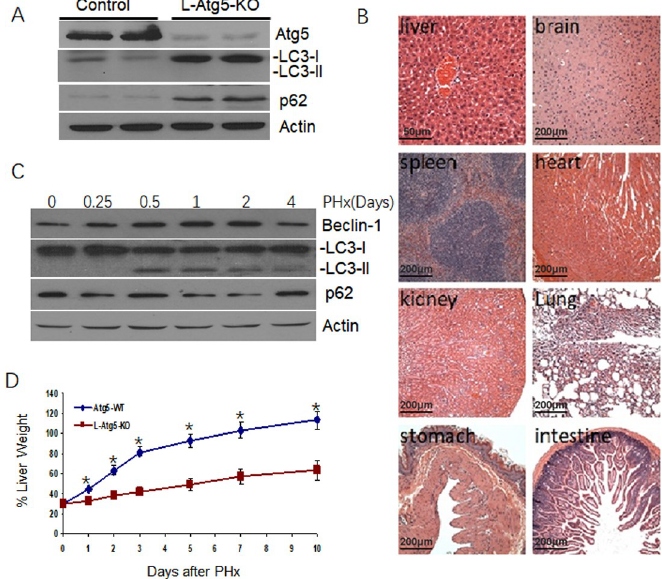
Fig 1. Development of hepatic tumors in L-Atg5-KO mice. (A) Immunoblot analysis of Atg5, LC3 and p62 in the liver of 10-weeks old Atg5-WT and L-Atg5-KO mice. Actin served as the loading control. LC3-I, non-lipidated LC3; LC3-II, lipidated LC3. Two or more tissue samples were analyzed to ensure the reproducibility of the results. (B) Hematoxylin and eosin staining of the liver tissue sections of Atg5-WT and L-Atg5-KO mice. (C) Autophagic activation in the regenerating liver after PHx. Immunoblot analysis of Beclin-1, LC3 and p62 in the liver at 6 hours, 0.5 daysy, 1 day, 2 days and 4 days after PHx in control mice. Actin served as the loading control. (D) Liver regeneration rates of Atg5-WT and L-Atg5-KO mice. Ten-weeks old Atg5-WT and L-Atg5-KO mice were subjected to 70% PHx and sacrificed at various time points after the surgery for liver weight measurements. Five mice were analyzed per time point and the results represented the mean. The average liver weight prior to PHx was defined as 100%. The results represent the mean ± s.e.m. of at least three mice. � , p < 0.05; �� , p < 0.01.